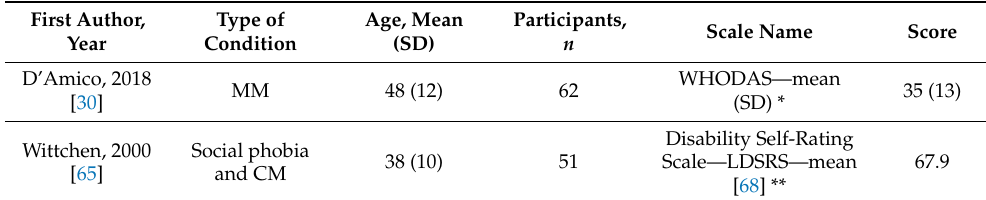
Table 3. Global functioning